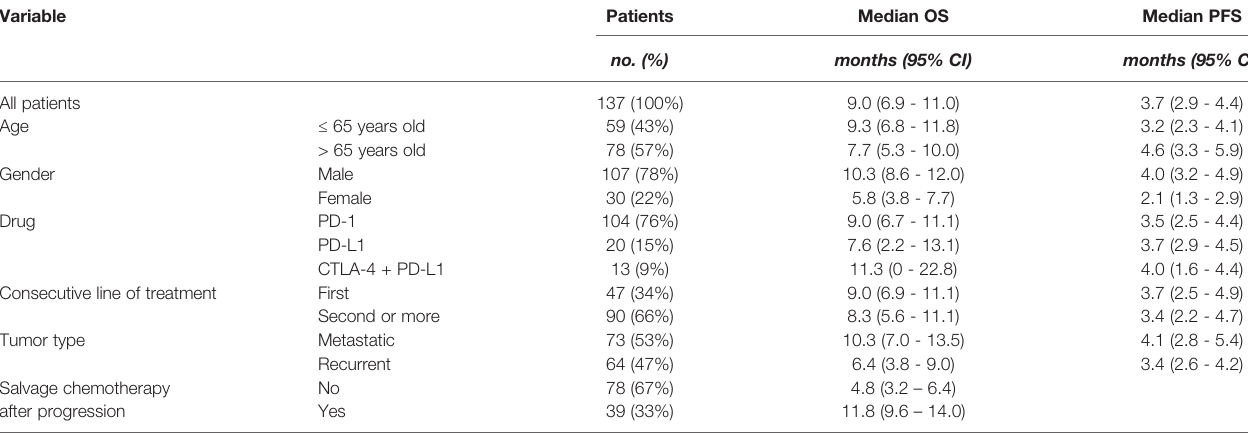
TABLE 1 | Overall survival (OS) and progression-free survival (PFS) according to predetermined demographic and clinical subgroups under immune checkpoint blockade treatment.